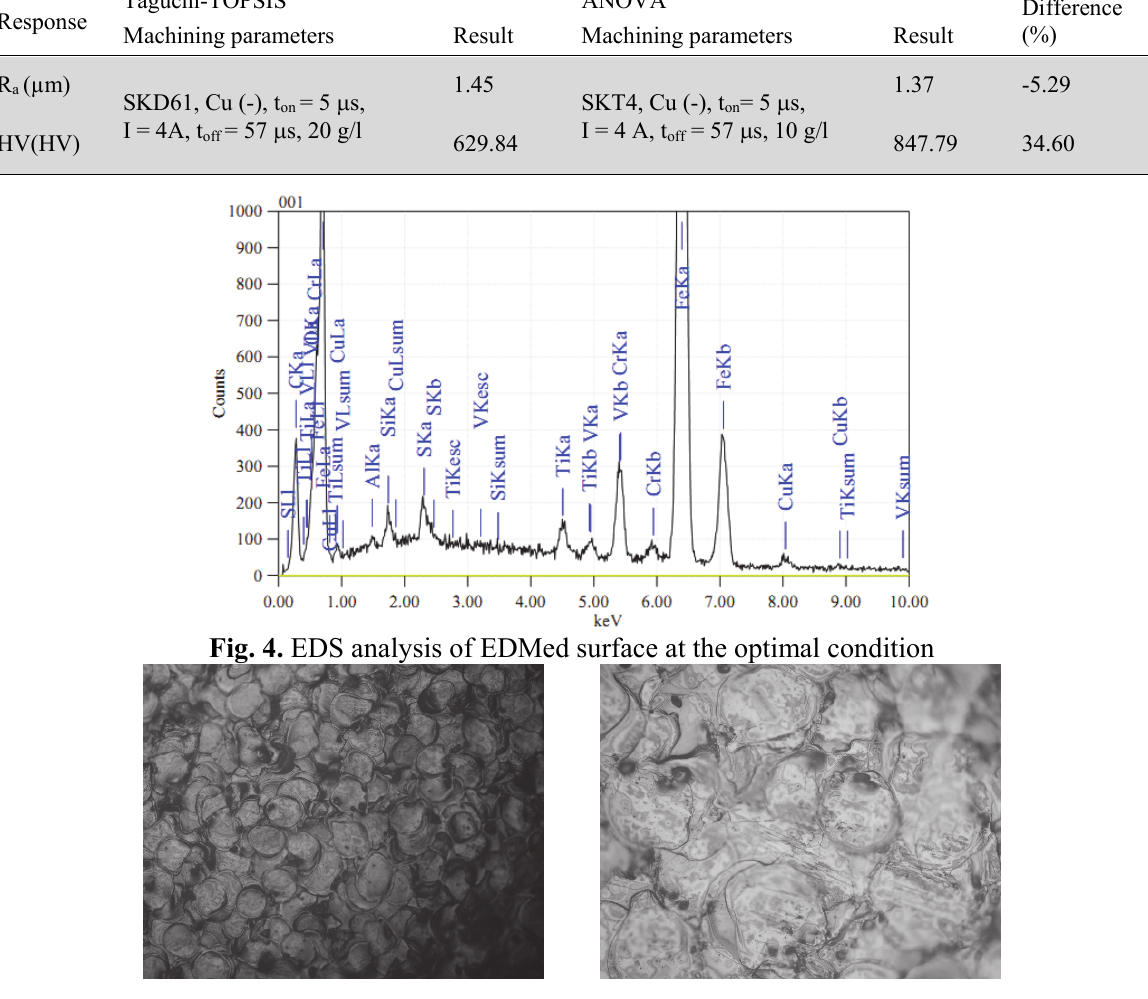
Fig. 5. SEM image of EDMed surface at the optimal